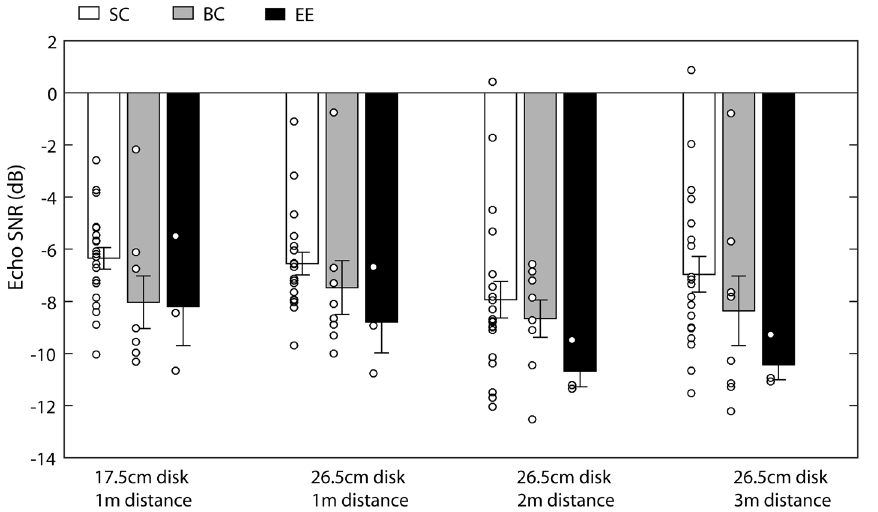
Figure 6. Echo SNRs for the different conditions and participant groups (SC – sighted controls; BC – blind controls; EE – expert echolocators). Bars represent means and error bars represent standard error of the mean across participants. Circles represent individual